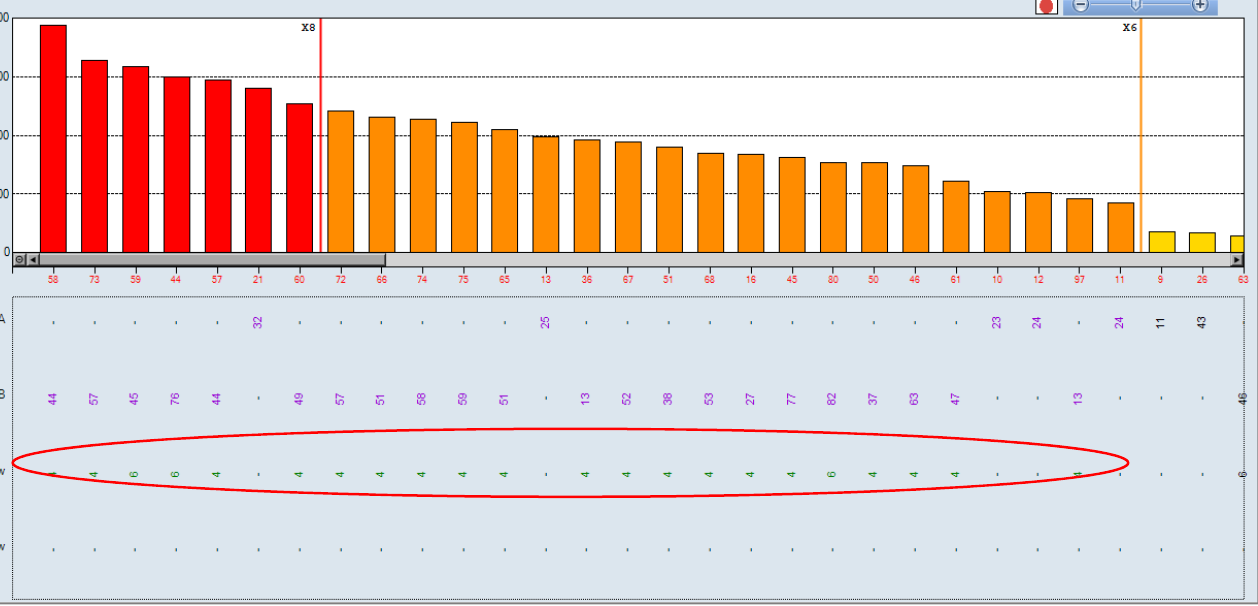
Figure 2. Single Antigen Class I at 6 February 2018: positive for all Bw4 specificities. The cutoff for positivity was set at 1500 MFI.